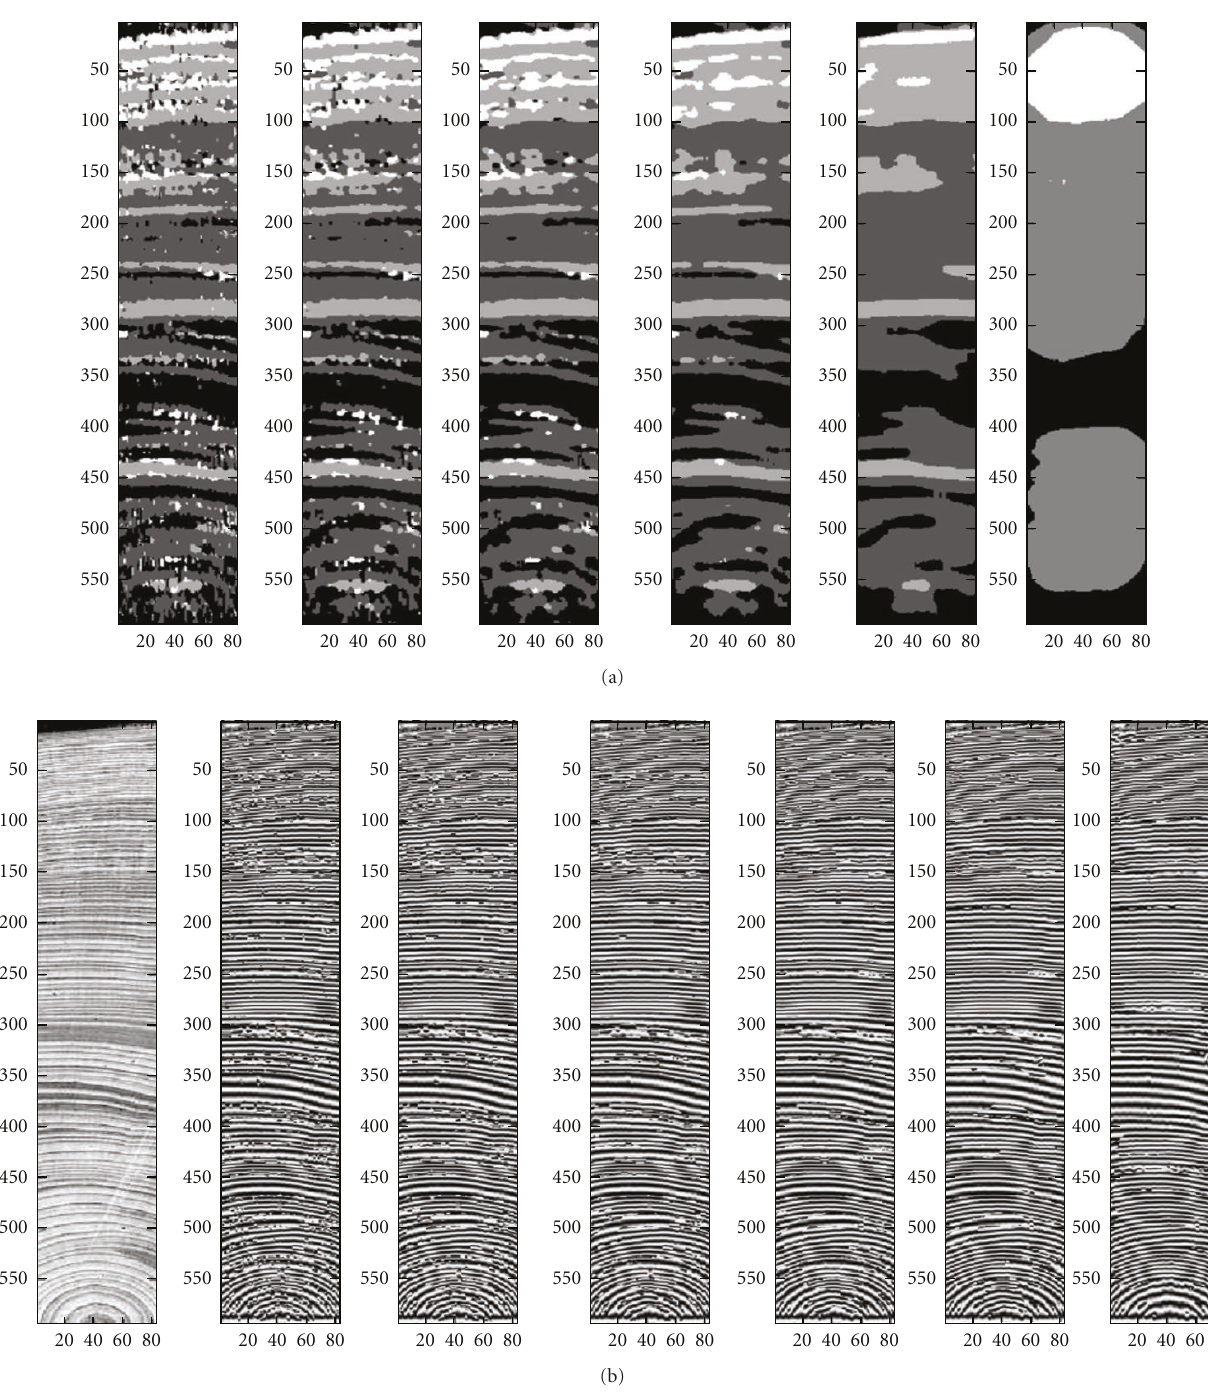
Figure 7: Median filtering continuity correction: (a) left to right: filter outputs without median filter, using median filters of sizes 3 × 3, 5 × 5, 9 × 9, 19 × 19, and 69 × 69. (b) Left to right: original image (spruce sample), FM image with no median filter, FM image with median filters of sizes 3 × 3, 5 × 5, 9 × 9, 19 × 19, and 69 × 69. Image courtesy: Henry